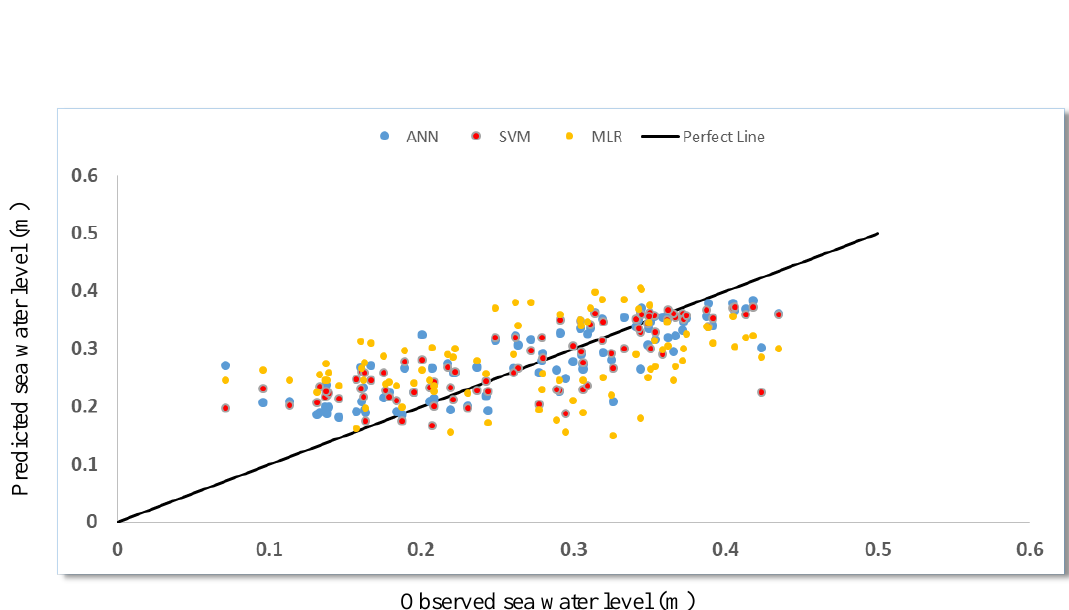
Figure 4. Scatter plot of seawater level for ANN and SVM in Bosphorus Strait (together with 1:1 perfect